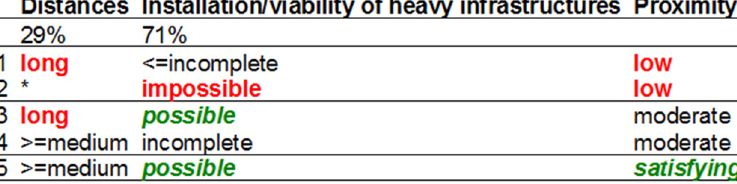
Figure A2. Utility function of the aggregated attribute Organization and Economics.